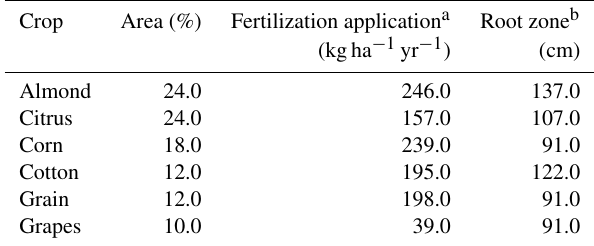
Table 3. Area distribution, fertilization application and root zone depth for the five crops considered in this